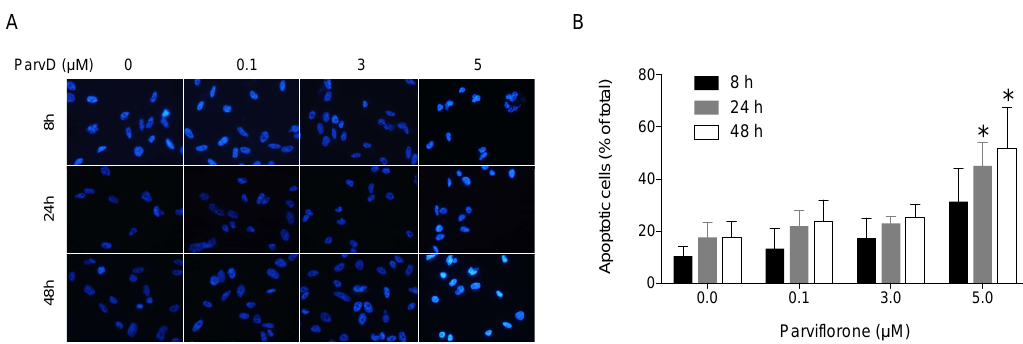
Figure 3. ParvD-mediated apoptosis in MDA-MB-231 cells was examined by nucleus morphological changes using DAPI. ( A ) Cells were treated with the indicated concentrations of ParvD for 8, 24, and 48 h, fixed stained with DAPI, analyzed under fluorescence microscopy, and the number of apoptotic cells was determined according to changes in nuclear morphology, including shrinkage, condensation, margination, and fragmentation of chromatin. Representative fields of cells are shown. ( B ) Summary results (means ± SD from at least 200 cells for each condition) show the percentage of apoptotic cells. * p < 0.05 (Student’s t -test, relative to untreated cells for the same incubation period).